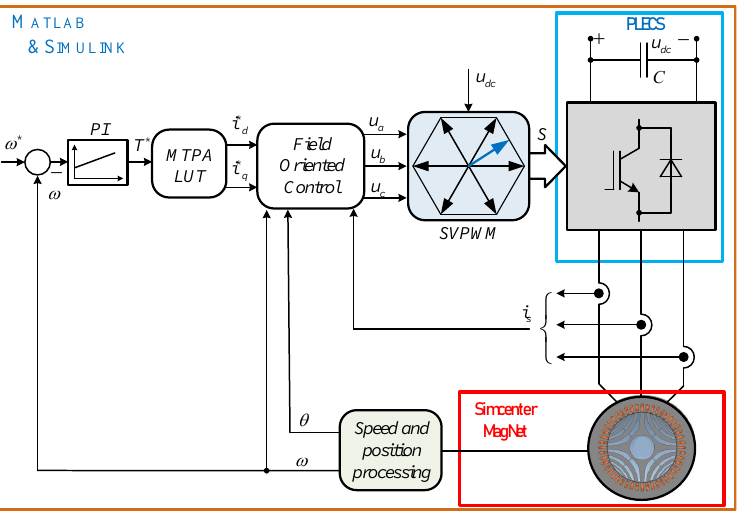
Figure 2. SynRel co-simulation model.